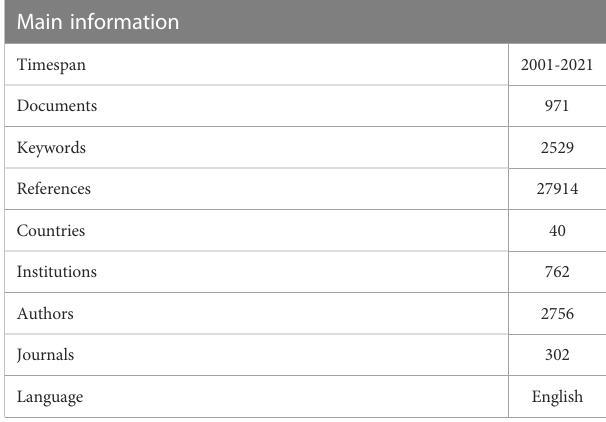
TABLE 1 Main information of the data set used in this study after the manual screening.